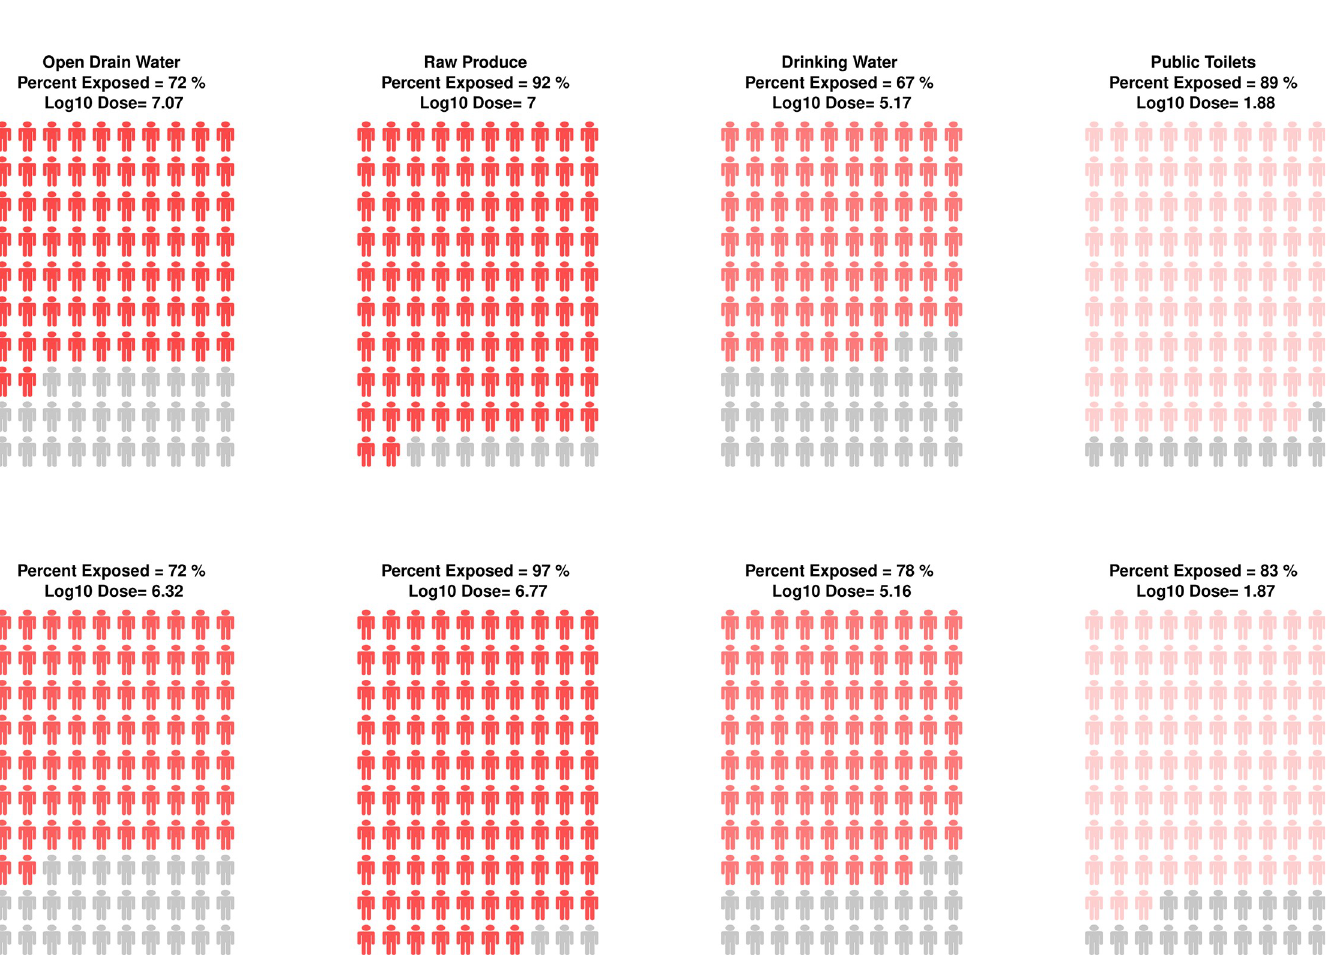
Fig 3. People Plot results for adults from simultaneous deployments of the SaniPath Tool by two data collection teams in Chorkor, Accra, Ghana (2016).